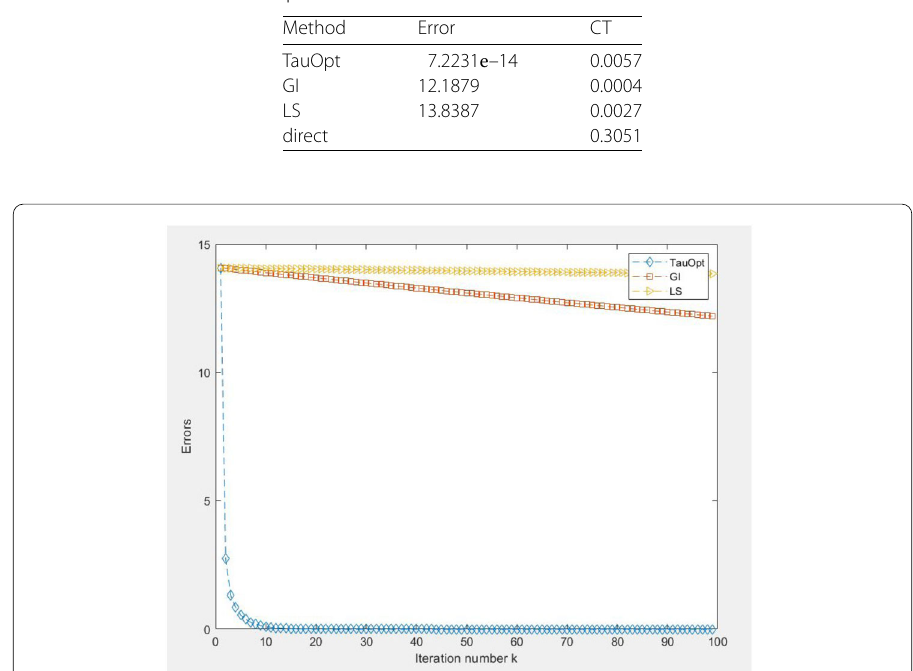
Figure 1 Errors for Example